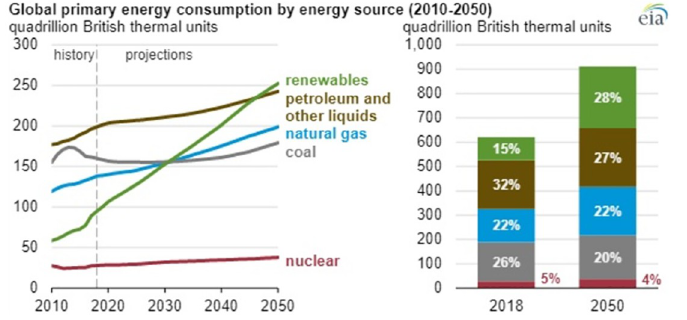
Fig 2. World’s energy consumption trend